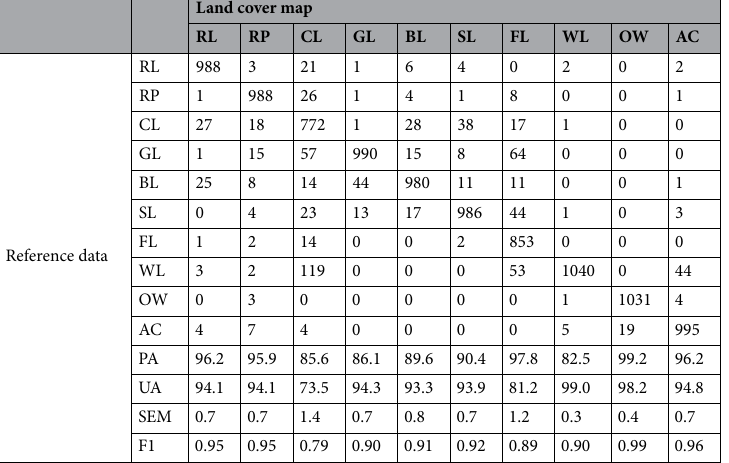
Table 1. Confusion matrix of the 2020 Vietnam-wide land use/cover map (Level 1) created from the integration of Landsat OLI, Sentinel SAR GRD and MSI satellite images with the random-forest-based algorithm. PA: Producer accuracy (%); PA: Producer accuracy (%); UA: User accuracy (%); SEM: Standard error of the mean for UA; F1: F1 score; Overall accuracy: 91.6%, and Kappa coefficient: 90.7 (%). RL: Residence; RP: Rice paddies; CL: Cropland; GL: Grassland; BL: Barren land; SL: Scrubland; FL: Forest land; WL: Wetland; OW: Open water; AC: